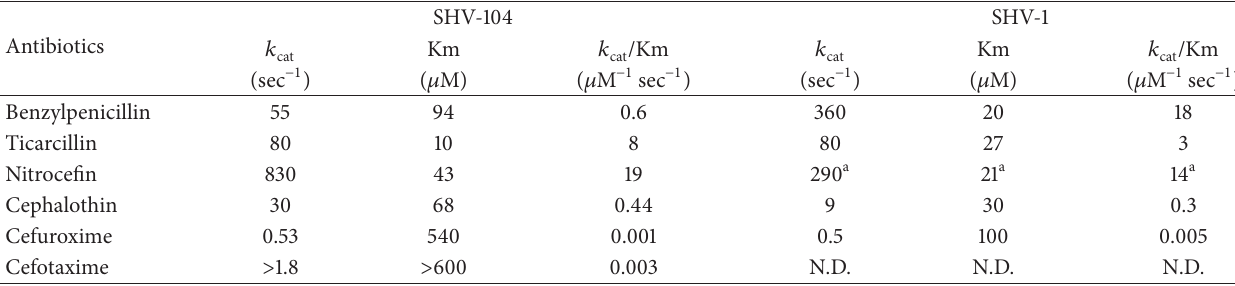
Table 3: Kinetics